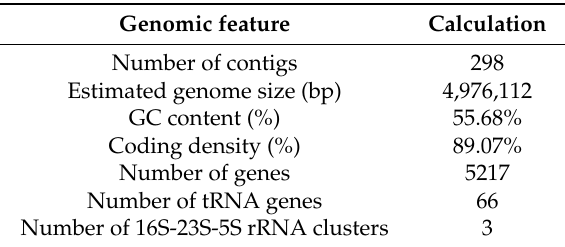
Table 3. General features of the Ochrobactrum sp. POC9 draft